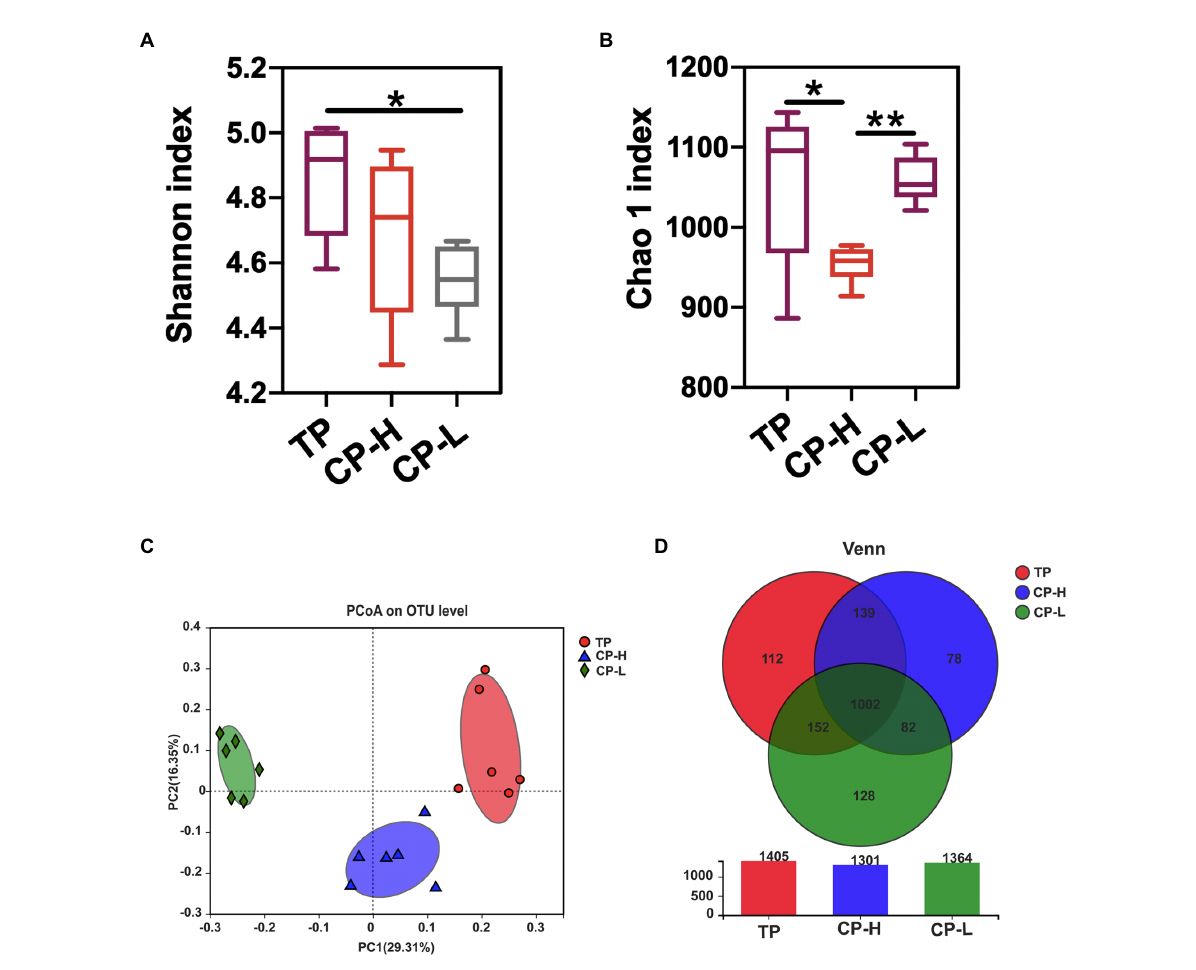
FIGURE 3 Effects of high-altitude hypoxic environment on gut microbiota diversity of pigs. TP: positive control group, CP-H: treatment group, CP-L: negative control group. (A) The Shannon index of microbiota in colonic chyme. (B) The Chao 1 index of microbiota in colonic chyme. (C) PCoA analysis of microbiota in colonic chyme at the OUT level. (D) The Wayne figures of microbiota in colonic chyme. Data are expressed as mean ± SEM ( n = 6). * indicating a statistically significant difference ( p < 0.05), ** indicating a highly significant difference ( p <